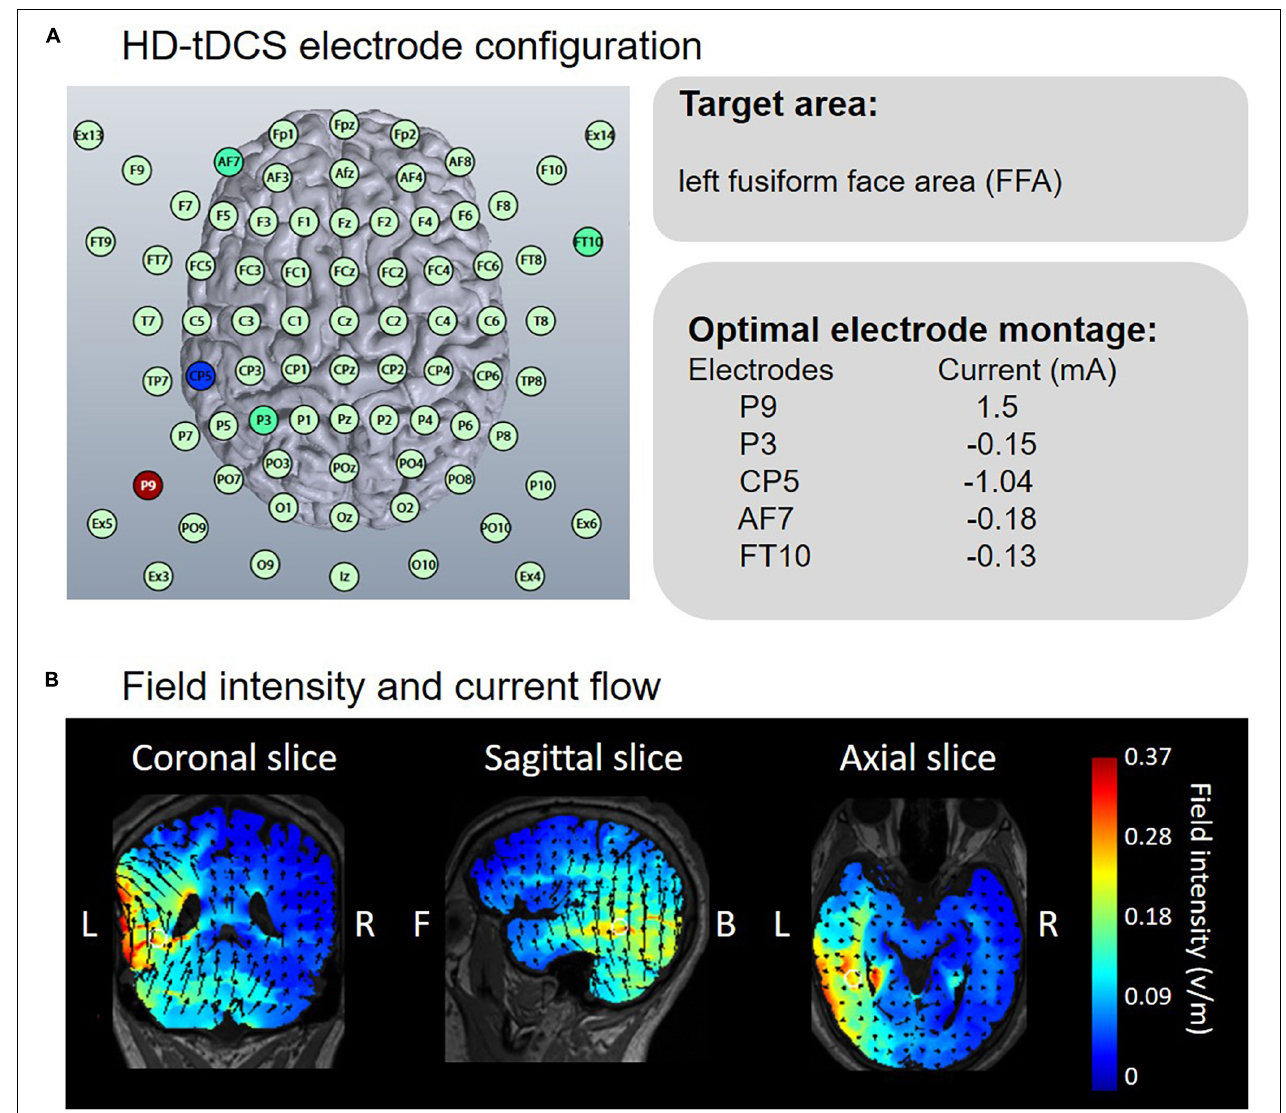
FIGURE 2 | Electrode configuration and simulated electric field in anodal HD-tDCS over the left FFA. (A) HD-Targets software defined the optimal electrode montage to focally stimulate the left FFA. (B) HD-Explore software modeled the field intensity and current